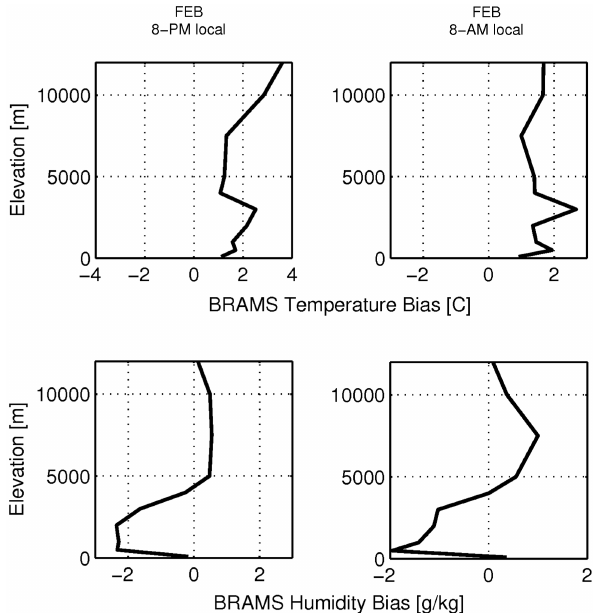
Figure C1. Comparison of model estimates with radiosonde data, differences in mean air temperature and specific humidity. Manaus, February 2003.